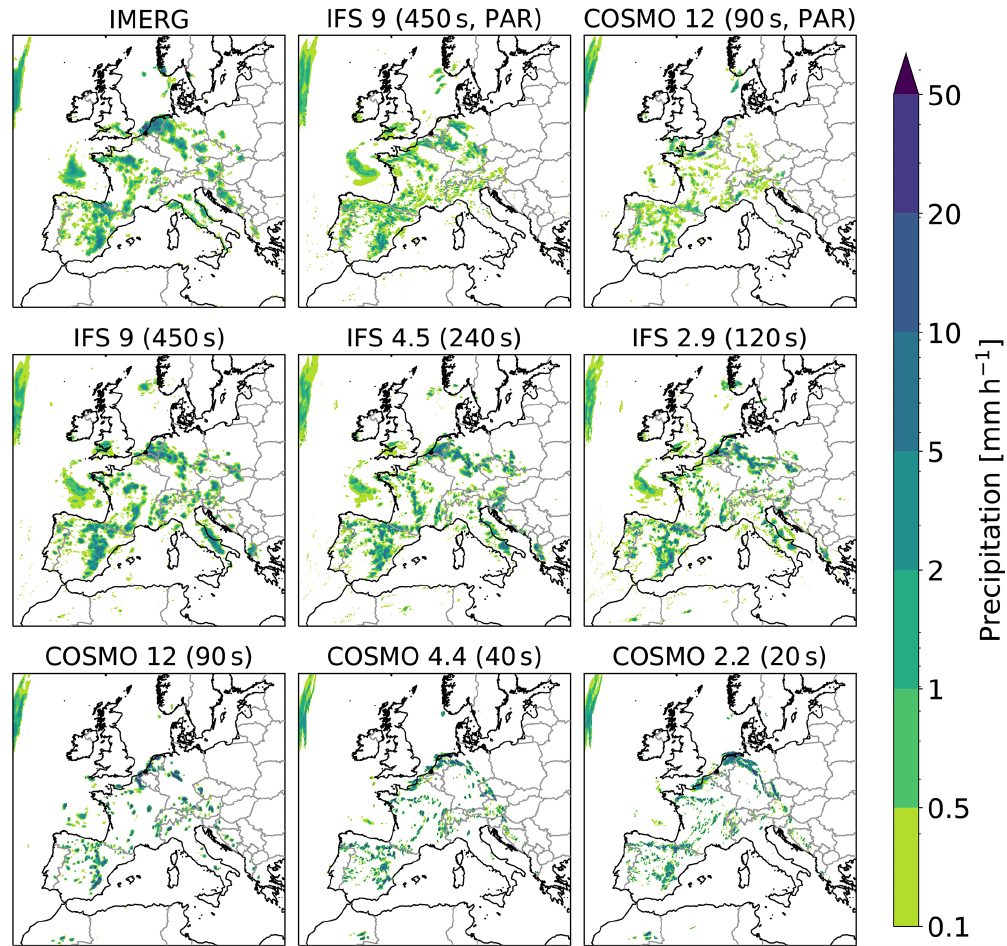
Figure 1. Accumulated hourly precipitation between 17:00 and 18:00UTC on 29 May 2018 over the European domain. The top left panel shows precipitation data obtained from the multi-satellite product IMERG which are provided on a 0.1 ◦ × 0.1 ◦ grid. The other panels show results from model runs, where the first number corresponds to the approximate grid spacing and the number in parenthesis is the respective time step. The term PAR denotes that the respective runs used parameterized deep